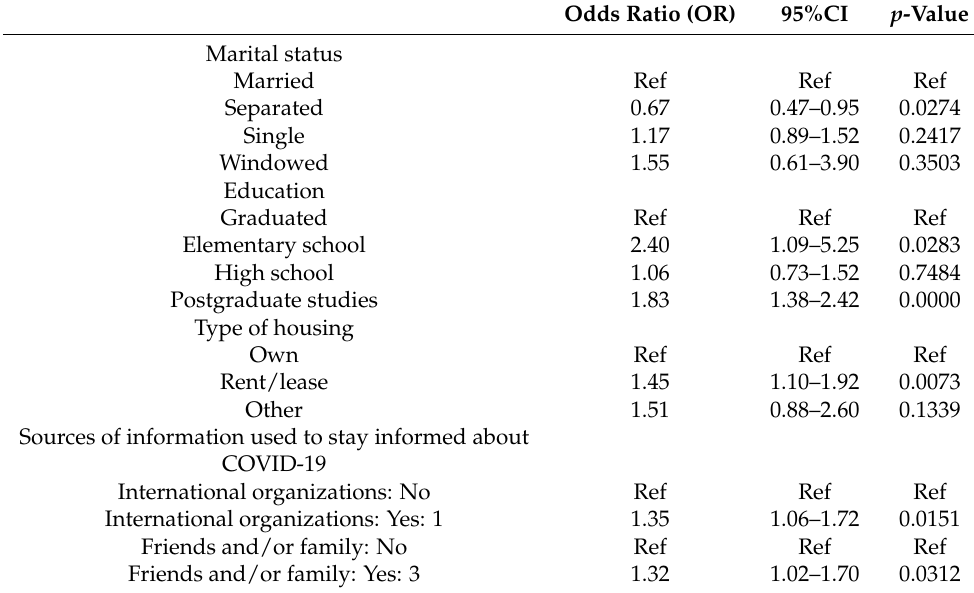
Table 5. Final models regarding the trust level toward primary care services ( n = 1018). Odds Ratio (OR) 95%CI p